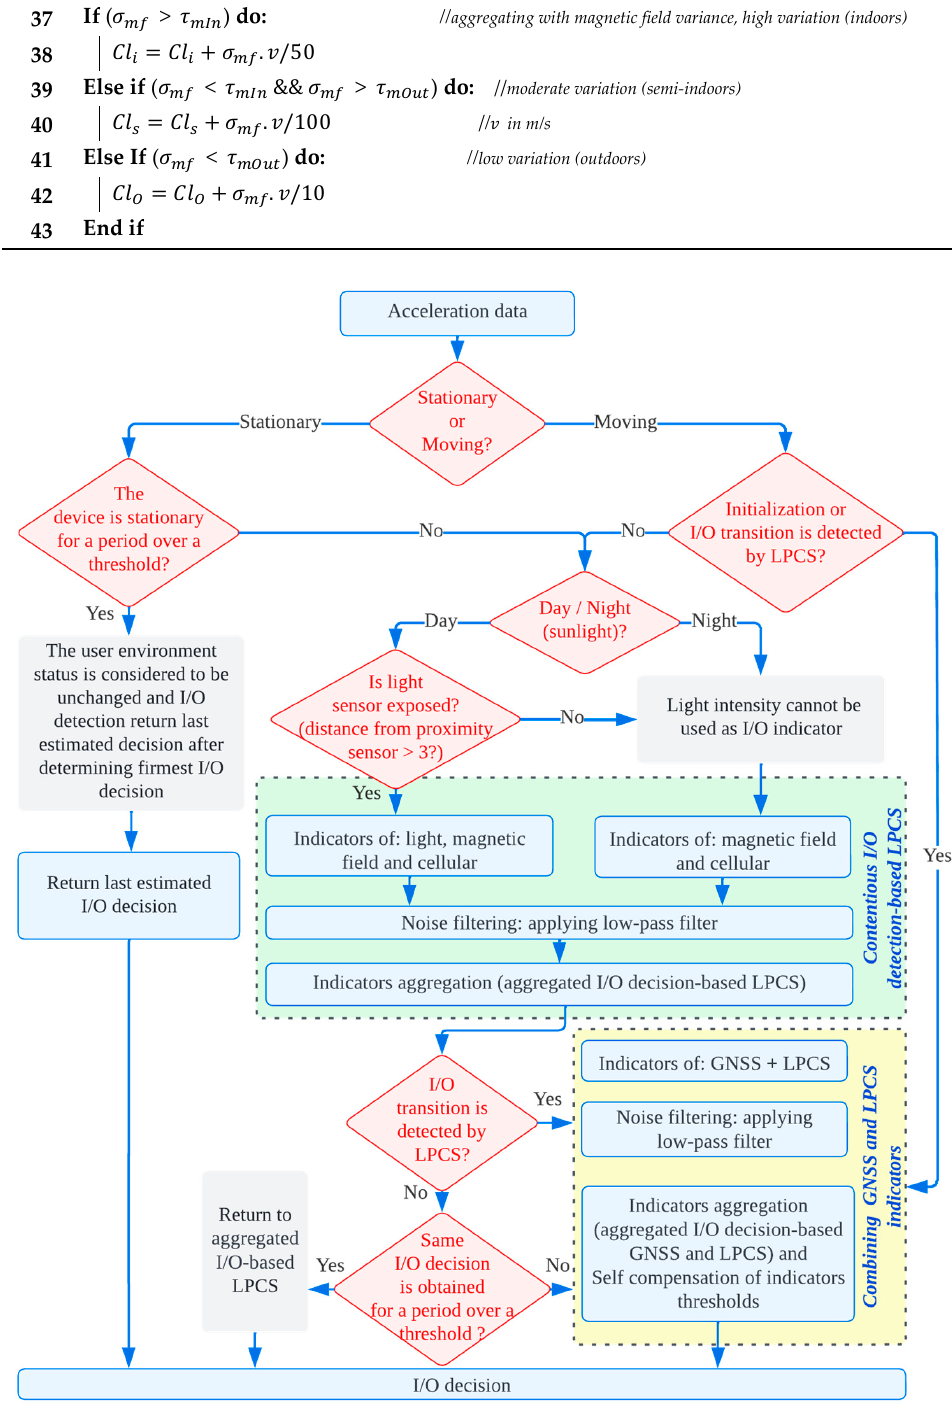
Figure 5. A flowchart of the proposed I/O detection algorithm. Algorithm 1: Aggregated I/O decision ‐ based LPCS and GNSS indicators